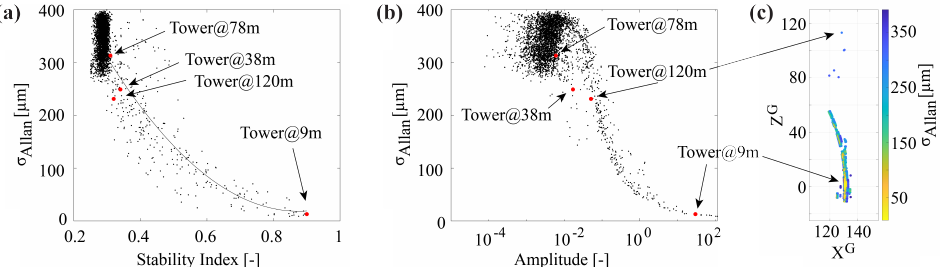
Figure 12. Visualization of bins in the vicinity of the turbine tower for MIMO-SAR acquisitions over a period of 945s with ( a ) showing the Allan deviation versus the stability index, ( b ) showing the Allan deviation versus the amplitude, and ( c ) showing the bins with an SI ≥ 0.31 in the global coordinate